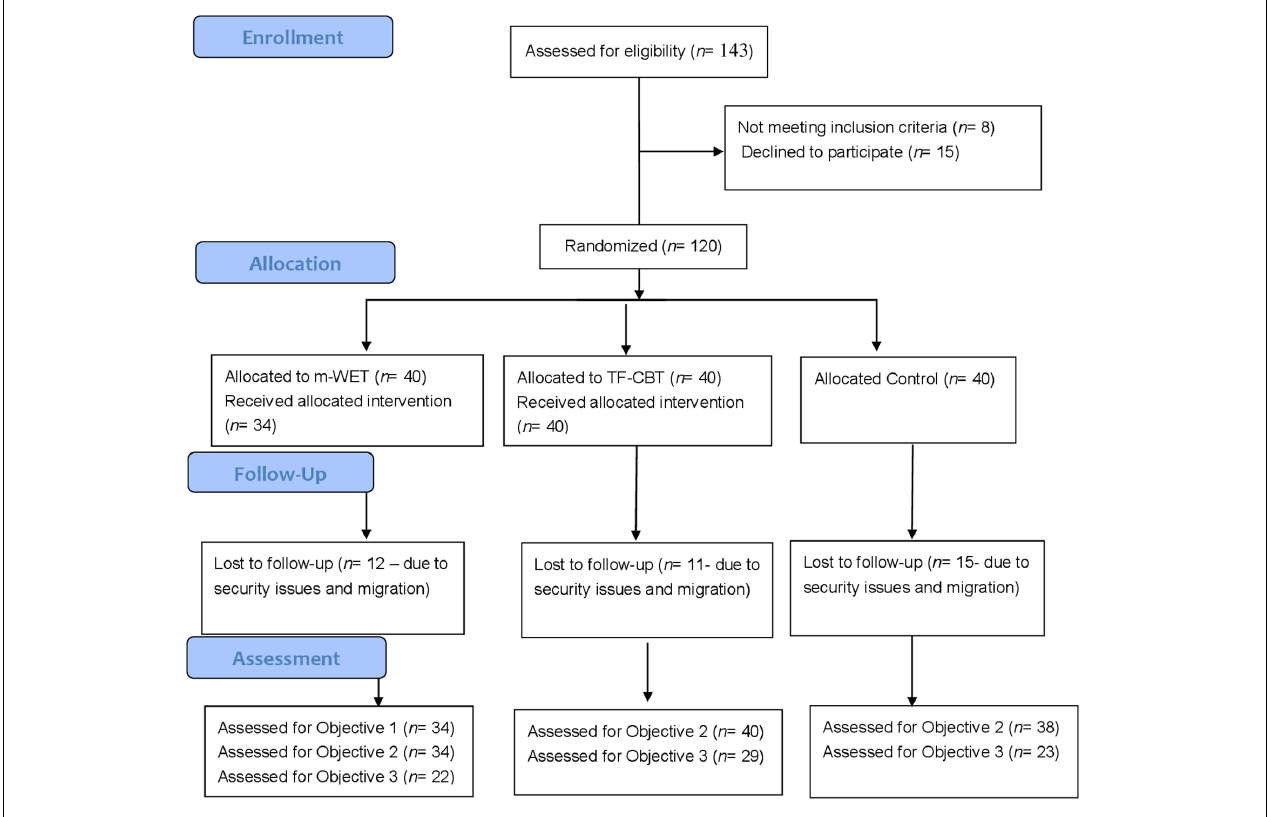
FIGURE 1 | CONSORT flow